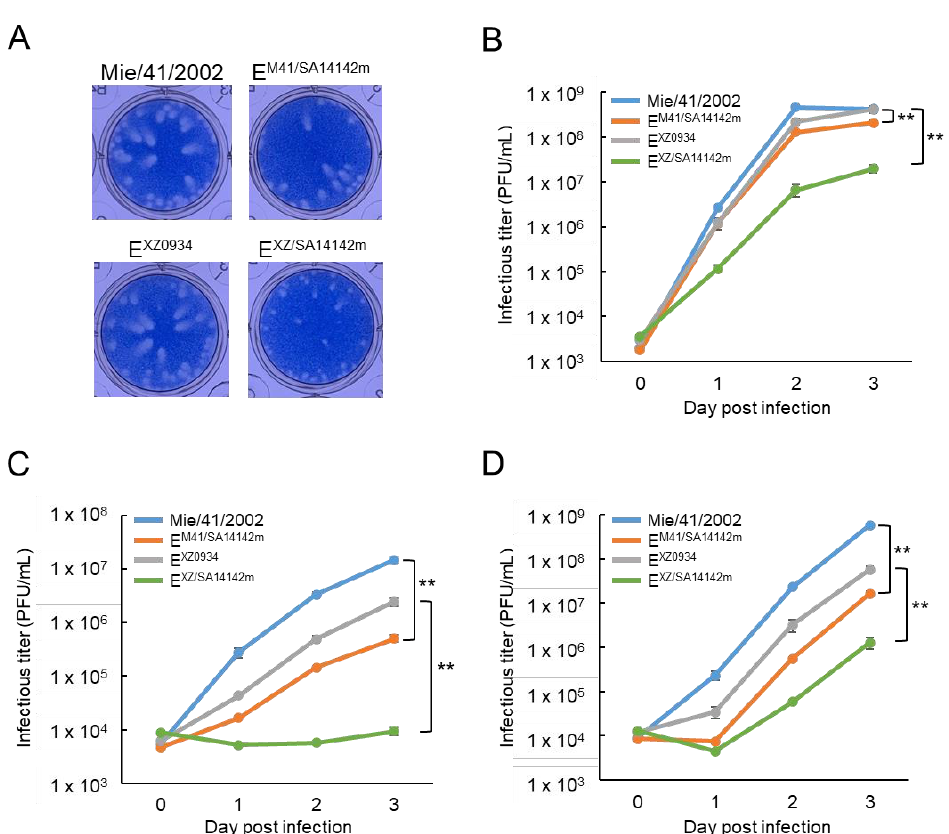
Figure 2. Growth properties of recombinant JEV strains. ( A ) Plaque phenotypes of Mie/41/2002, rJEV-E M41/SA14142m -M41 (E M41/SA14142m ), rJEV-E XZ0934 -M41 (E XZ0934 ), and rJEV-E XZ/SA14142m -M41 (E XZ/SA14142m ) in Vero cells. ( B , C ) Growth curves measured for Mie/41/2002, E M41/SA14142m , E XZ0934 , and E XZ/SA14142m in Vero ( B ), Neuro-2a ( C ), and IMR-32 ( D ) cells. Cells were plated into 6-well culture plates and infected with the JEV strains at a multiplicity of infection (MOI) of 0.1 PFU/cell. Values: means ± standard deviation from three independent inoculations. Significance (parental virus vs. mutant virus, day 3) was analyzed using the student’s t -test (** p < 0.01).